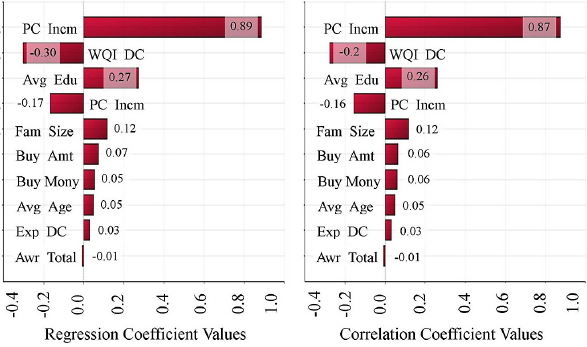
Figure 4. Tornado diagrams for sensitivity analysis of WTP